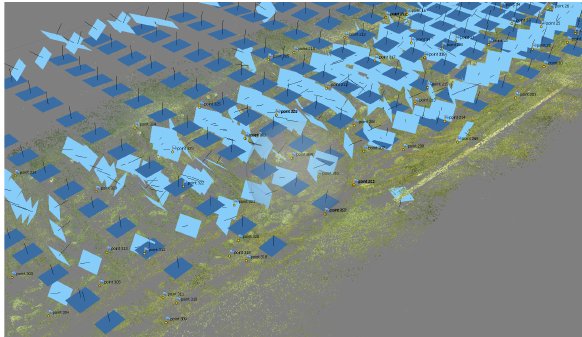
Figure 4. A detail of the point cloud extracted from the photoset. Color squares mark reconstructed camera positions: blue – for off nadir photos, cyan – for oblique